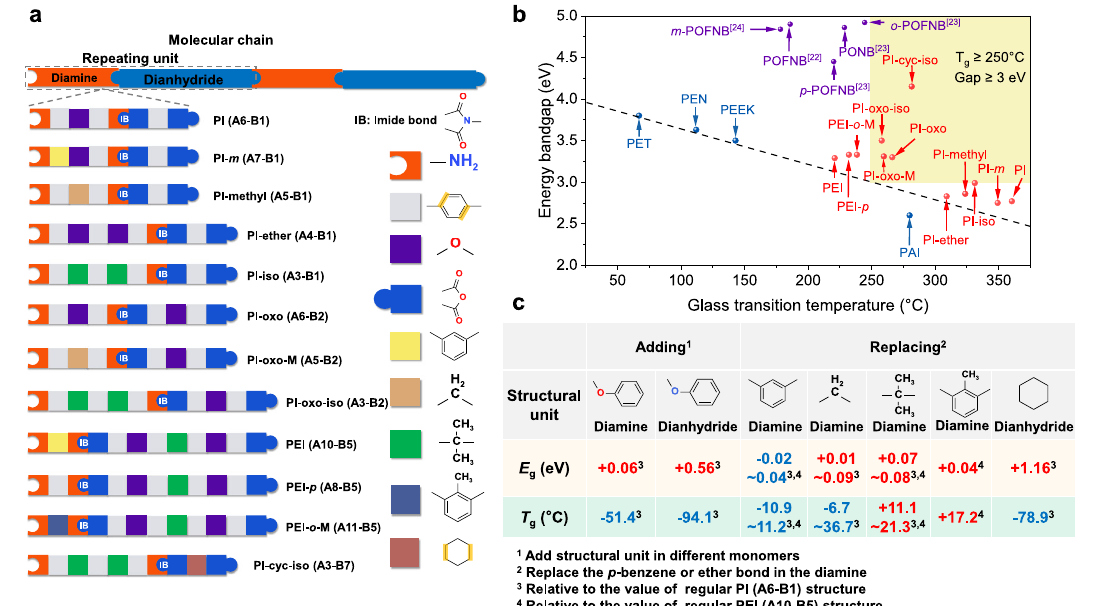
Fig. 3 | Molecular structure and property characterization. a Molecular struc- ture puzzle of 12 polymers. We split the molecular structure into nine structural units, i.e .,amino, p -benzene,ether,anhydride, m -benzene,cyclohexane, o -toluene, methylene and isopropyl. b Comparison of electrical and thermal properties between polymers synthesized in this work, polymers reported previously and